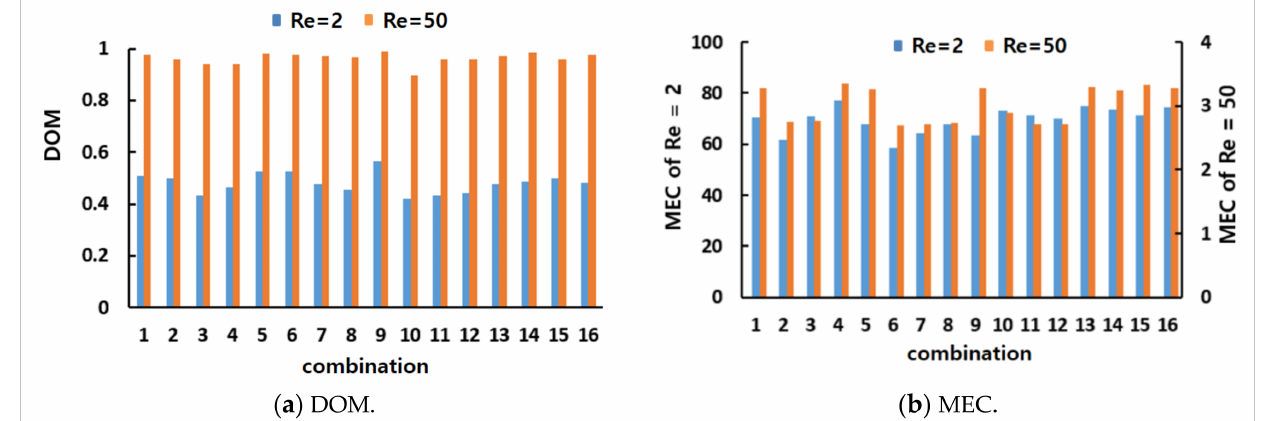
Figure 12. Comparison of the mixing performance of the sixteen